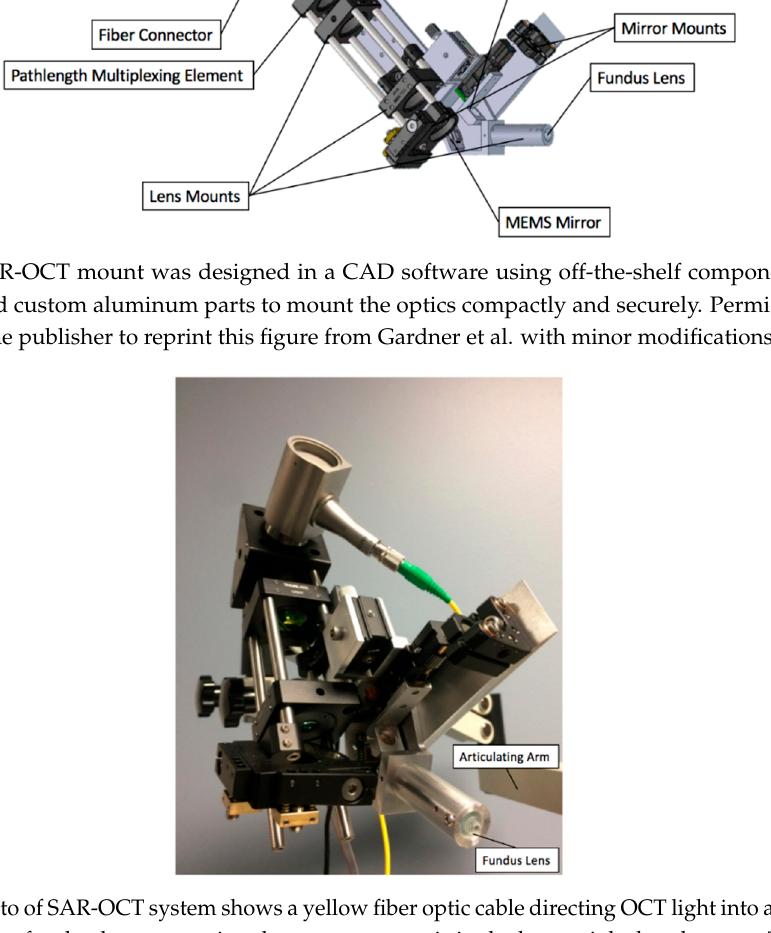
Figure 7. Photo of SAR-OCT system shows a yellow fiber optic cable directing OCT light into a reflective collimator. The fundus lens contacting the mouse cornea is in the lower right-hand corner. The entire system is mounted on an articulating arm for ease of movement and positioning. Permission was granted by the publisher to reprint this figure from Gardner et al. with minor modifications [19].